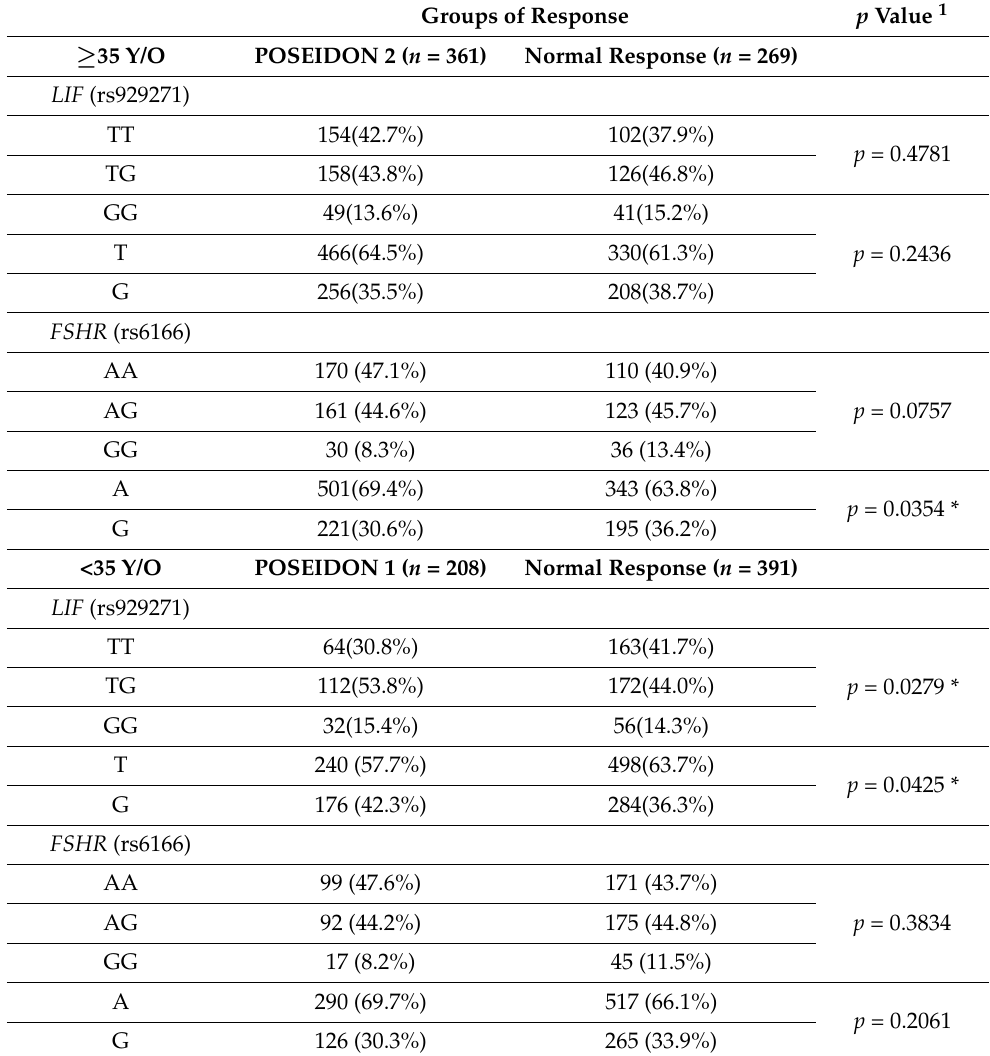
Table 3. Distribution of LIF (rs929271) and FSHR (rs6166) in older ( ≥ 35 years, n = 630) and younger (<35 years, n = 599) patients with AMH ≥ 1.2